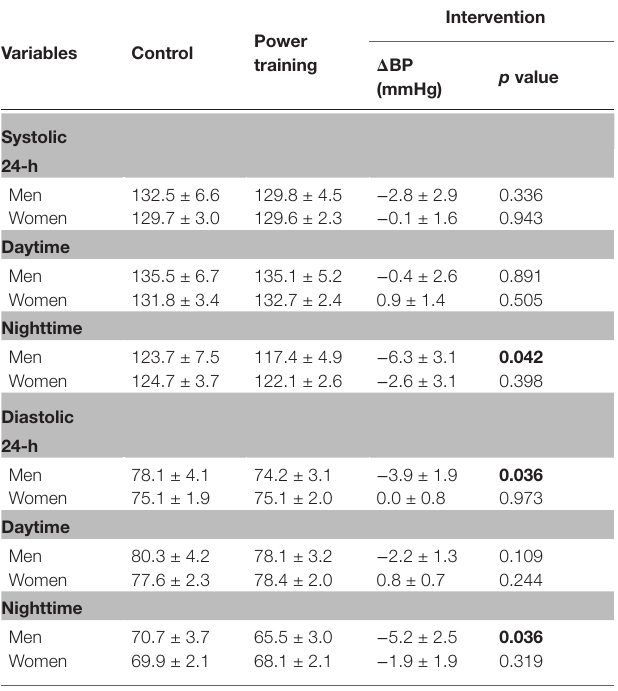
TABLE 4 | Exploratory analyses of ambulatory blood pressure, separated by sex, after the power training and control sessions.